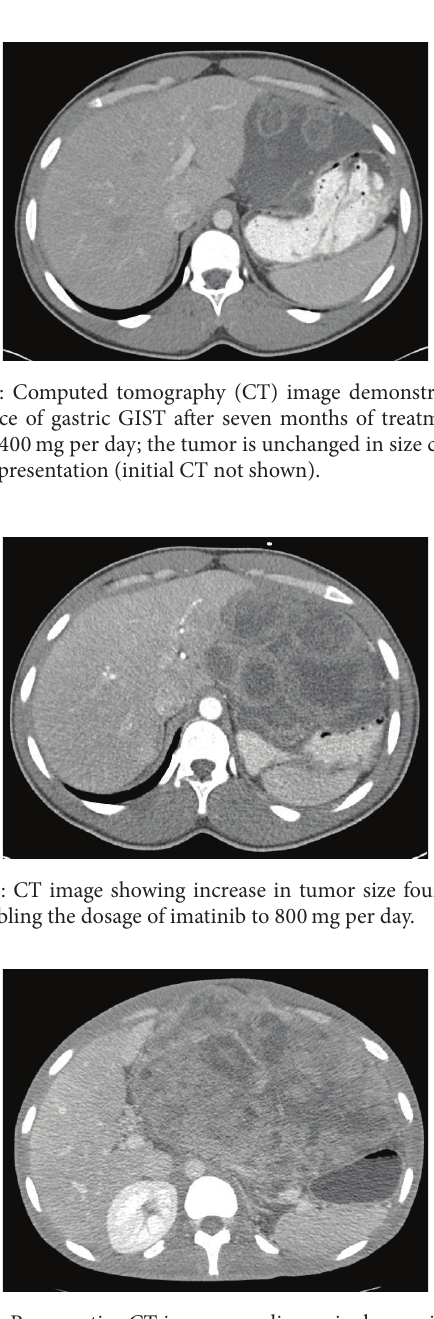
Figure 3: Preoperative CT image revealing a single massive tumor (30 × 21 ×